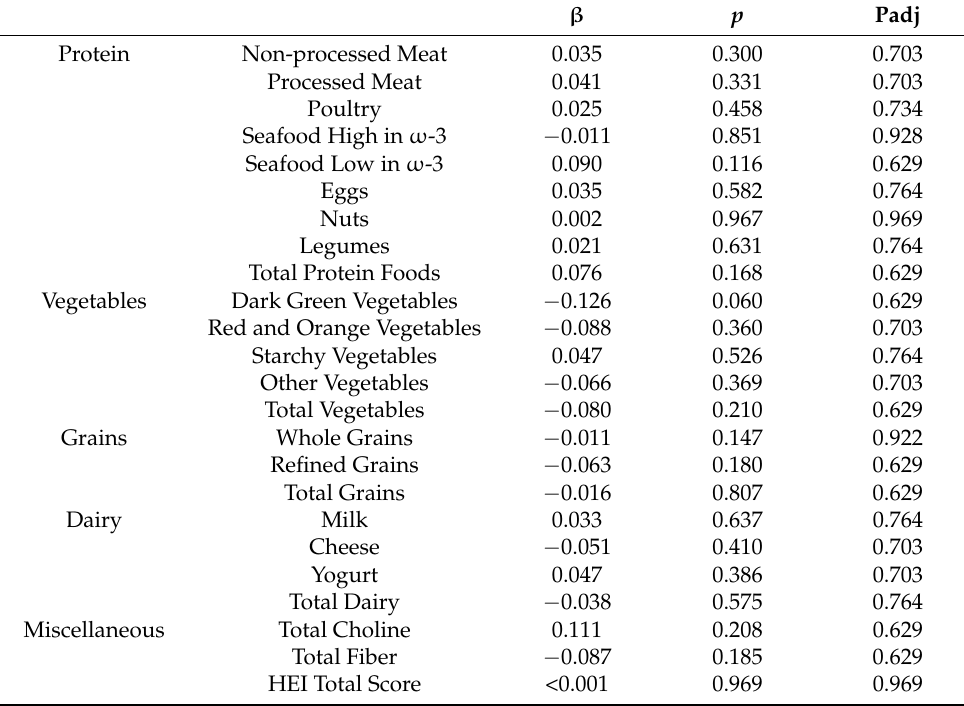
Table 2. Relationships between fasting plasma TMAO and recent dietary